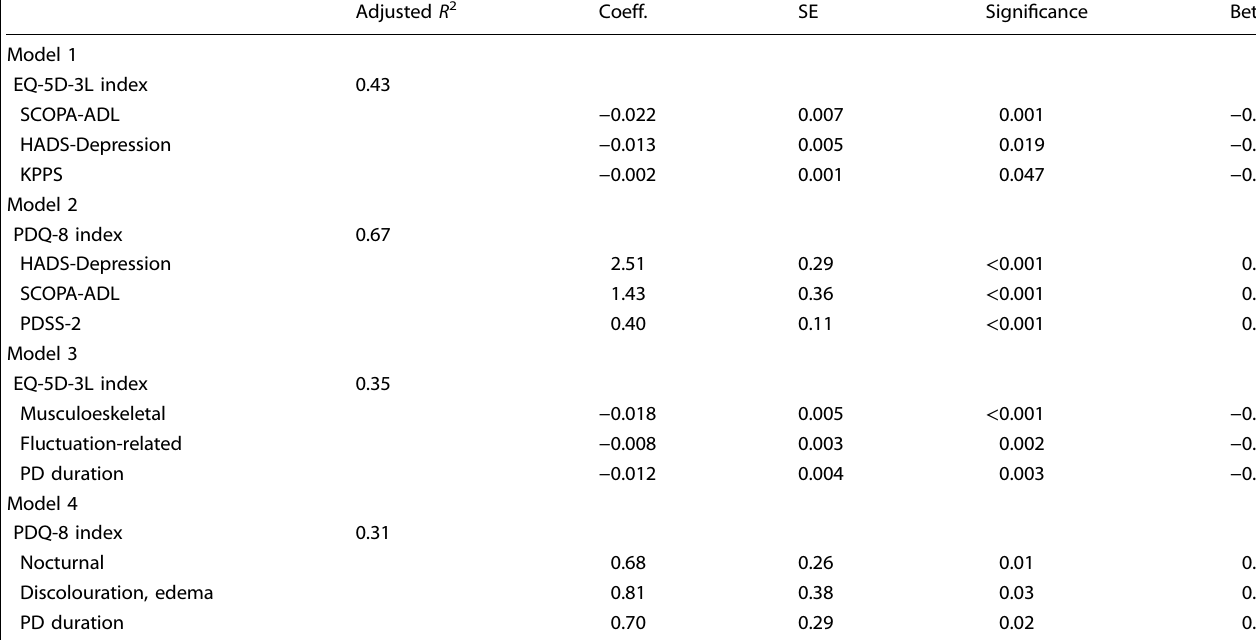
Table 4. Results of the multiple linear regression models Adjusted R 2